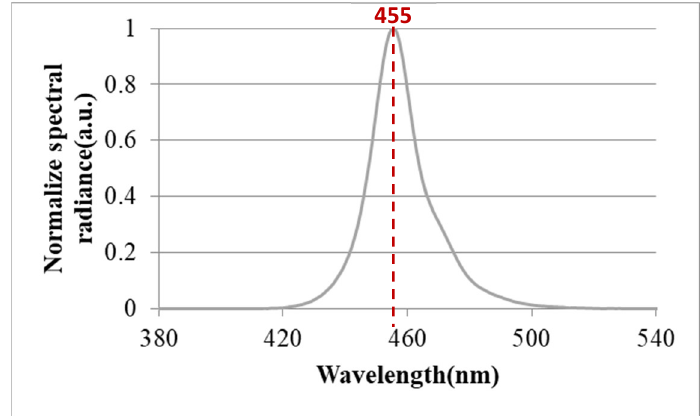
Figure 3. Normalized electroluminescence spectrum of mini-LEDs. The light distribution curve of the mini-LEDs is plotted in Figure 4. In the figure, the full width at half maximum (FWHM) of the light angle was 140°, and the black and red curves represent the light distribution curves of the horizontal and vertical sections, respectively.